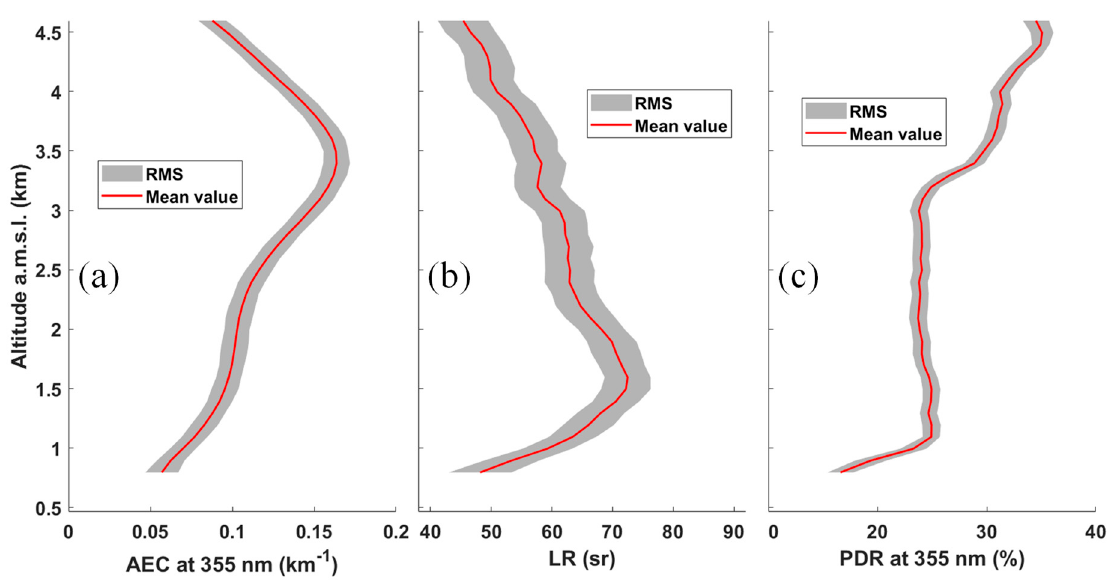
Figure 9. Mean vertical profiles (red solid line) with 50 m vertical resolution of ( a ) the aerosol extinction coefficient (AEC), ( b ) lidar ratio (LR), and ( c ) particle linear depolarization ratio (PDR) between 14 June 2019, 22:00 and 15 June, 06:00 LT. The uncertainties on the lidar-derived optical parameters are shown as gray areas.